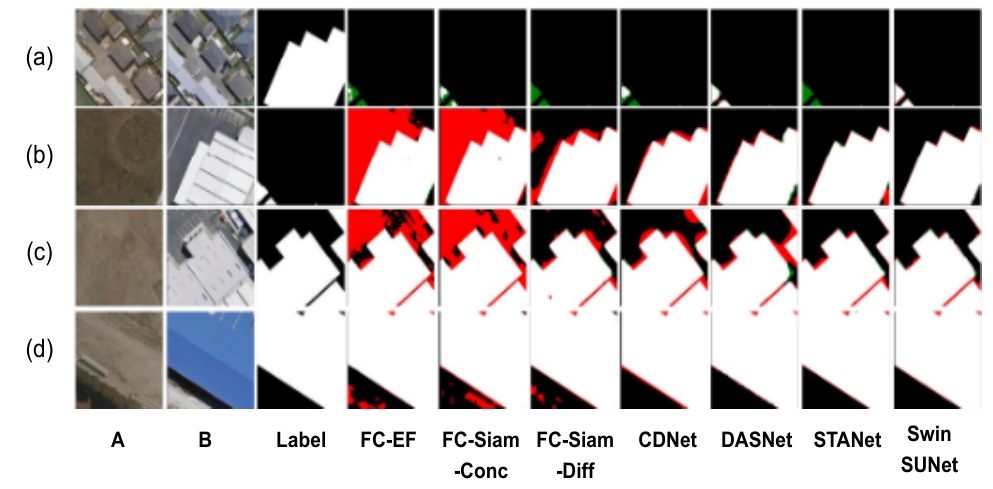
Figure 8. Results of different CD methods visualized, such as FC-EF [62], FC-Siam-Conc [62], FC- Siam-Diff [62], CDNet [63], DASNet [64], STANet [61] and SwinSUNet [56], compared to ( a – d ) sample imagery sets, such as the WHU-CD [60] test set. Various colors were utilised to convey different denotations; white represents true positive, black represents true negative, red represents false positive and green represents false negative. Figure is from